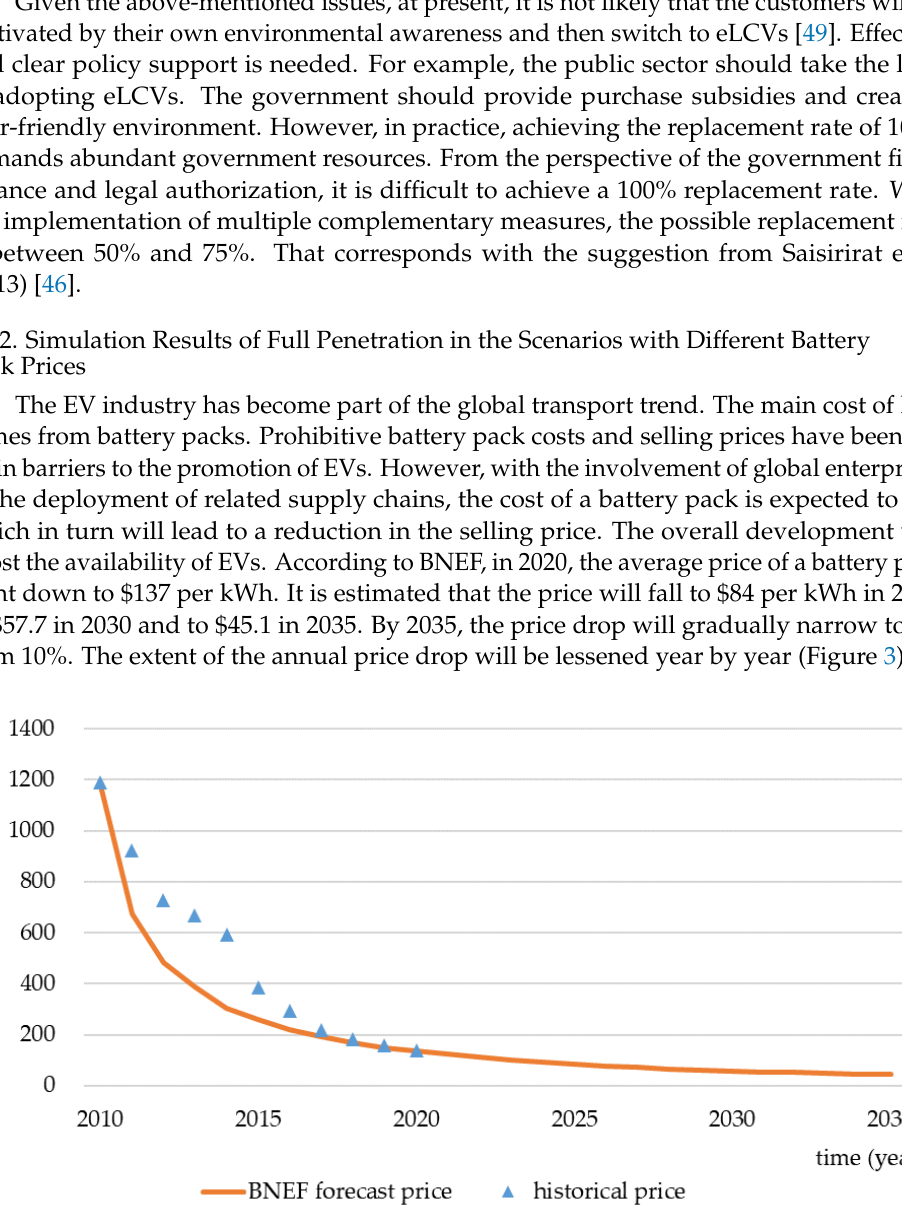
Figure 3. Forecasts of the on-board battery pack price. Source: Illustrated by the data from BNEF (2021), Electric Vehicle Outlook 2021 [7].